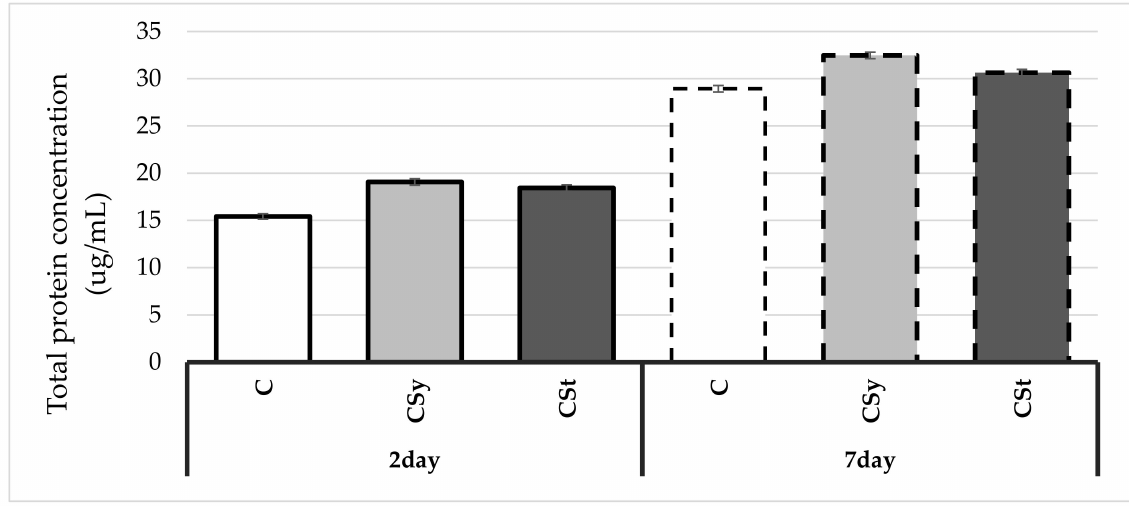
Figure 1. Protein concentrations in the 2- and 7-day-old workers’ hemolymph after two methods of supplementation with hemp extract: C–control (pure sugar syrup), Csy–hemp extract in syrup, Cst–hemp extract on strips (Two-Way ANOVA: supplementation method: F (2,59) = 62.085, p = 0.000; days of supplementation: F (1,59) = 2266.3, p = 0.000; supplementation method*days of supplementation F (2,59) = 2.2833, p =